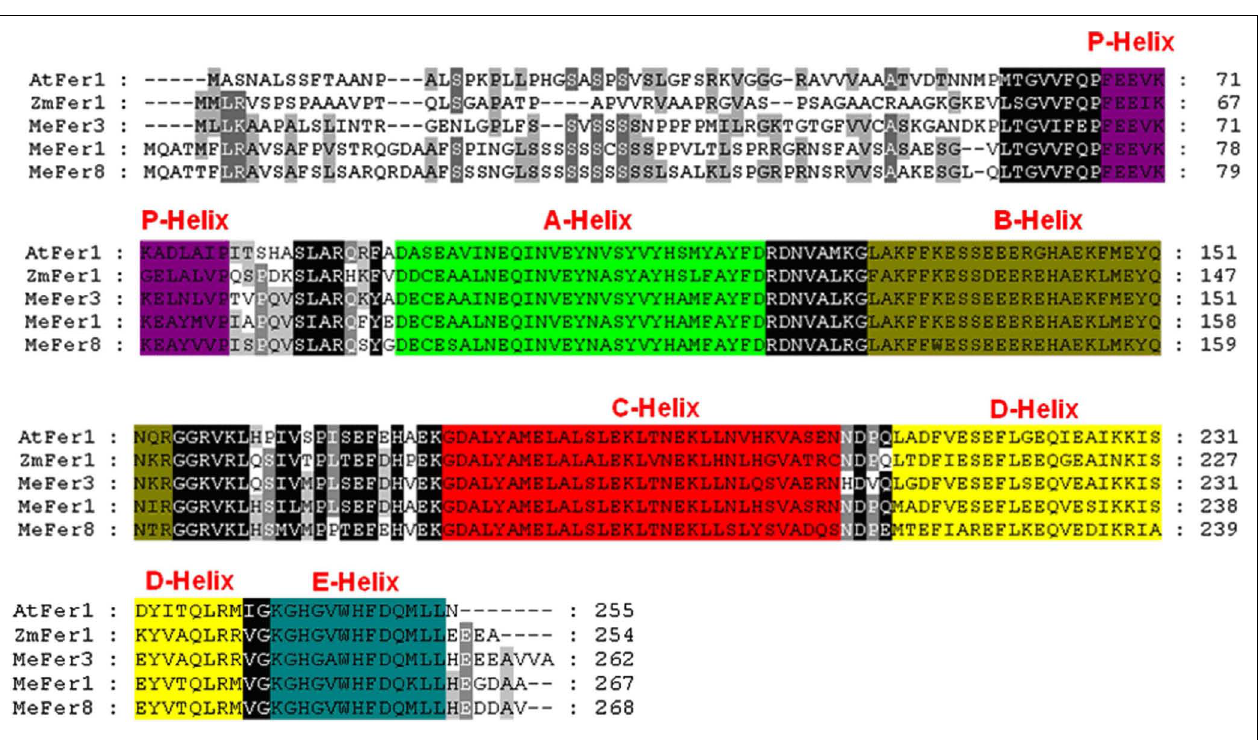
FIGUREA7 | Comparison of the putative amino acid sequences of cassava ferritin and other plant ferritin proteins. Identical and conservative amino acids are shaded in black and gray, respectively. Dashes indicate gaps.